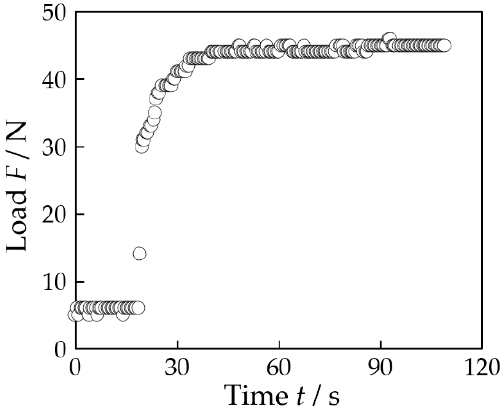
Figure 12. Load during drawing of the copper tube at the die reduction R e of 0.17 and the drawing speed ratio β of 1.10.